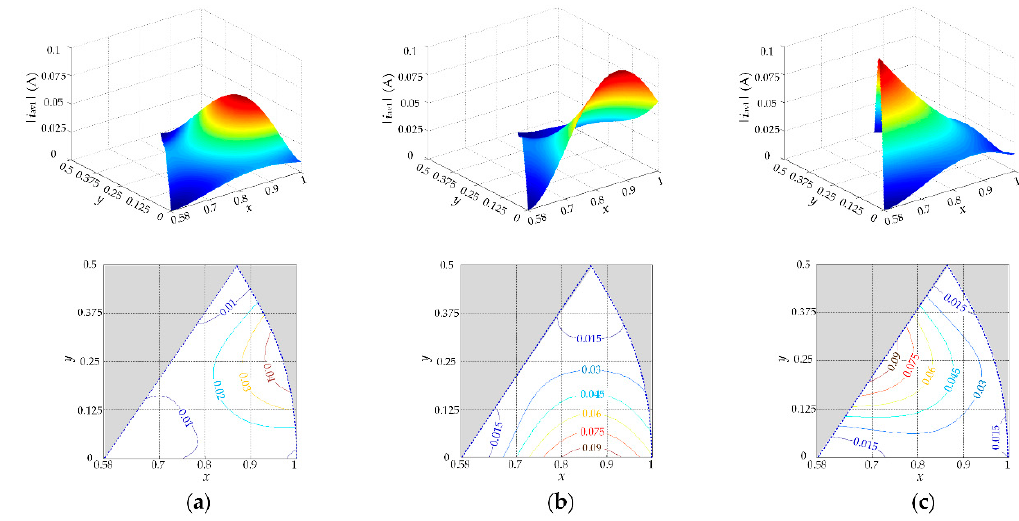
Figure 4. Dependency of | i av1 | on the modulation index m and reference vector angle θ in Triangle 3 (cid:79) ③ of Sector Z 1 : ( a ) Sequence 31; ( b ) Sequence 32; ( c ) Sequence 33.